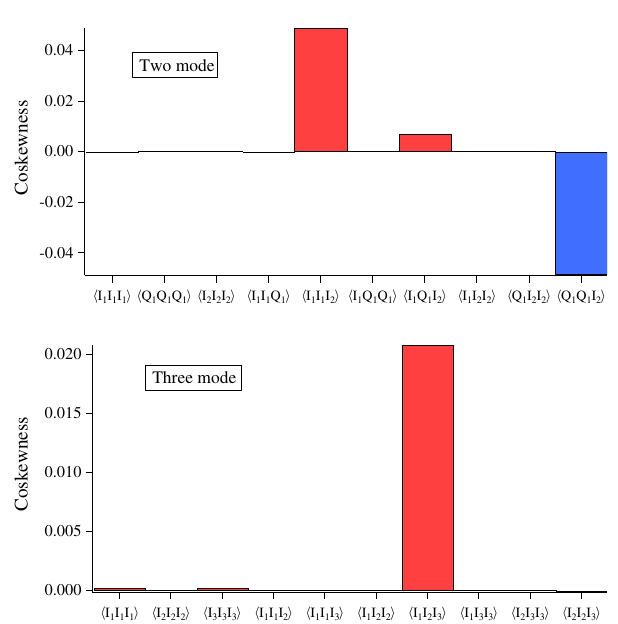
FIG. 4. Measured coskewness in (top) the two-mode case and (bottom) the three-mode case. In the two-mode case, we consider ˆ ˆ I Q 1 , and ˆ I 2 as a representative sample. the three quadratures 1 , The pump frequency is chosen such that mode 1 is the degenerate mode. Accordingly, we expect only h I 2 1 I 2 i , h Q 2 1 I 2 i , and h I 1 Q 1 I 2 i to be nonzero, which is what is observed. Their relative values are determined by the pump phase [Eq. (B5)]. In the three-mode case, ˆ I we consider the quadratures of all three modes. As expected, the only nonzero term includes all three modes, i.e., h I 1 I 2 I 3 i